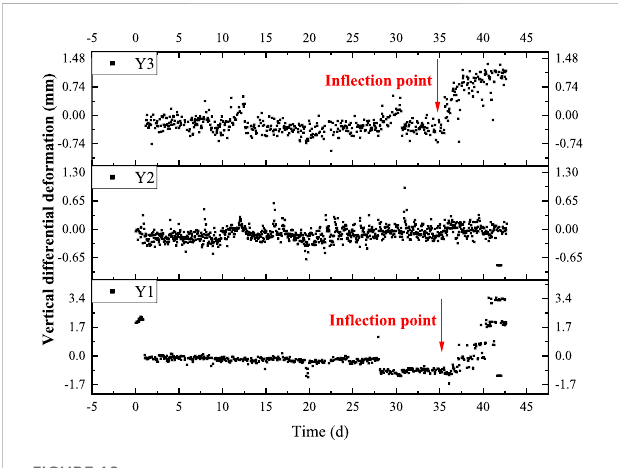
FIGURE 18 Scatter diagram of time domain analysis of monitoring results of vertical differential deformation of joints at different measuring points.